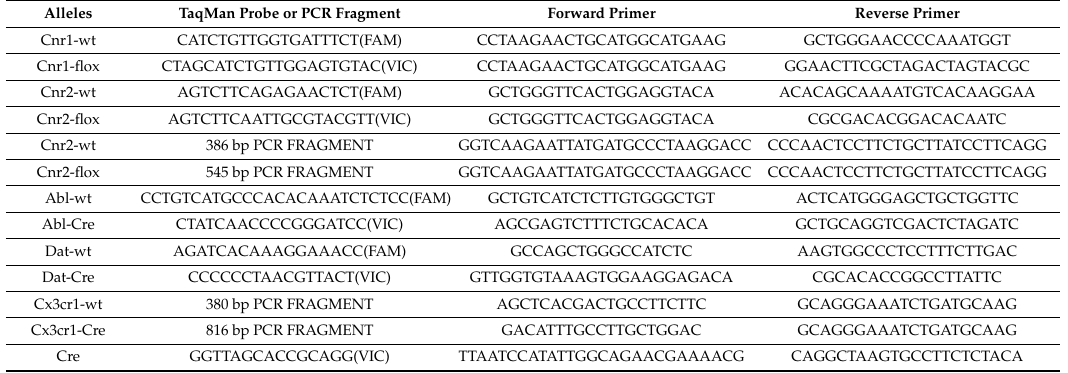
Table 2. Nucleotide sequences of TaqMan probes and primers for PCR fragments for genotyping of the transgenic